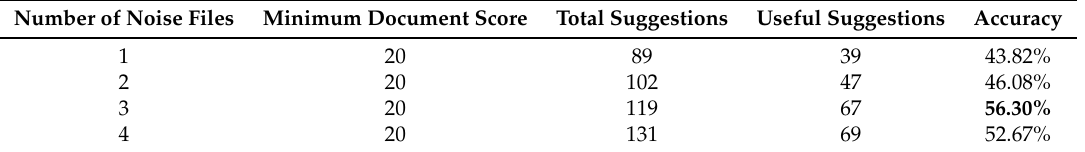
Table 2. Base approach + Noise files system – number of noise files impact.